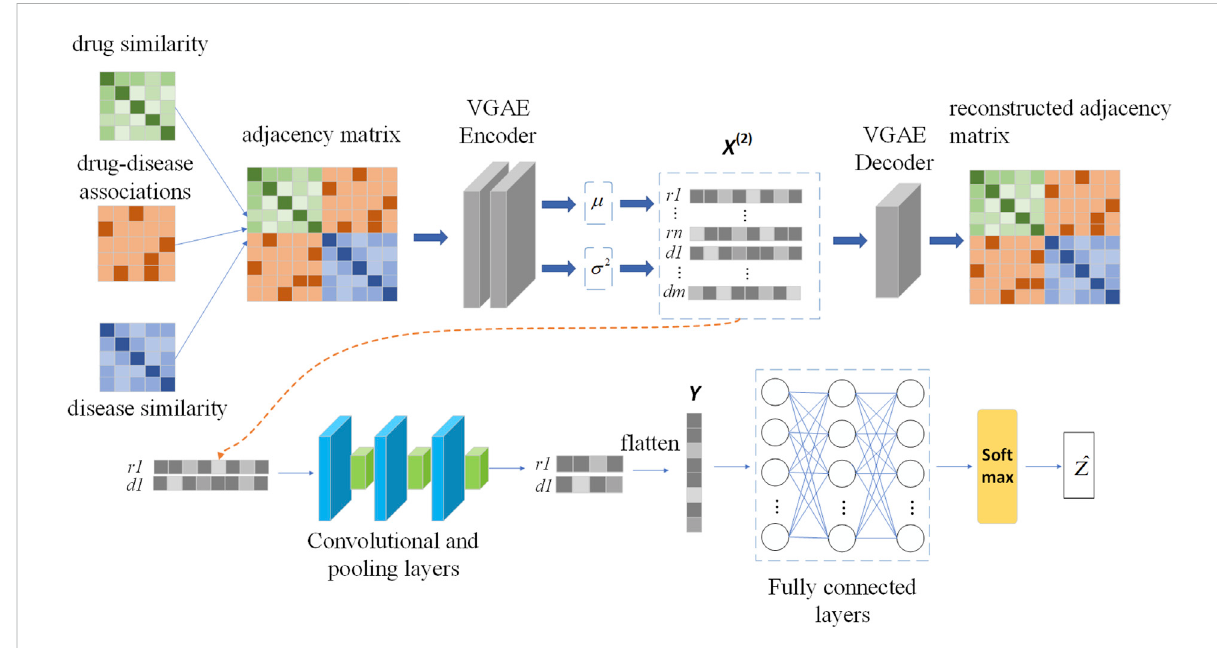
FIGURE 2 The work fl ow of VGAEDR